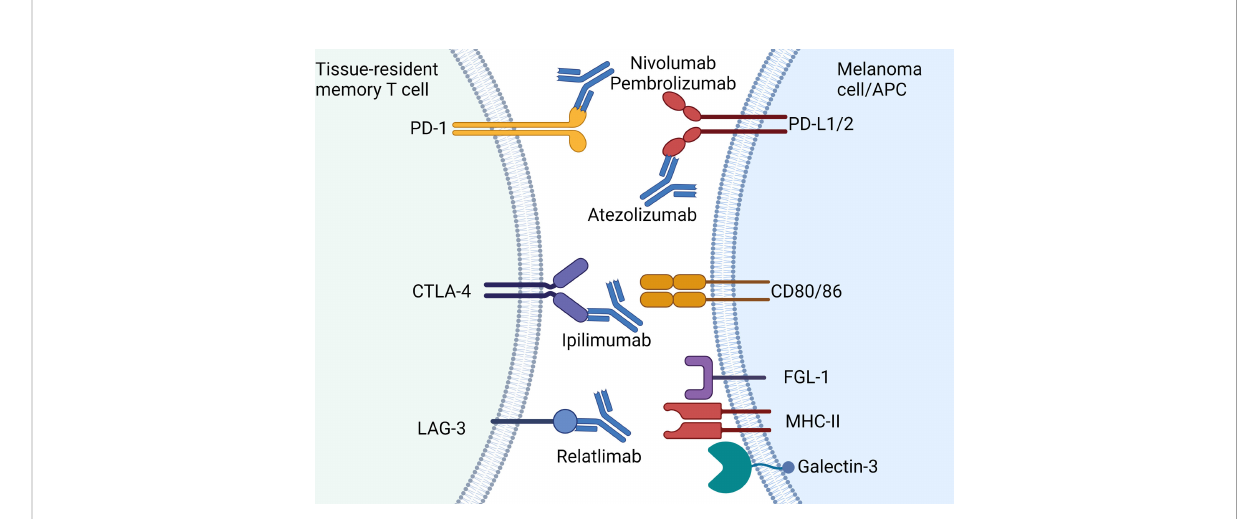
FIGURE 3 Current approved immune checkpoint inhibitors for the treatment of melanoma: Immune checkpoint molecules expressed by T RM and the approved antibodies including PD-1 (nivolumab, pembrolizumab), PD-L1 (atezolizumab), CTLA-4 (ipilimumab) and LAG-3 (relatlimab). Note atezolizumab is only approved for use in combination with vemurafenib-cobimetinib. Created with